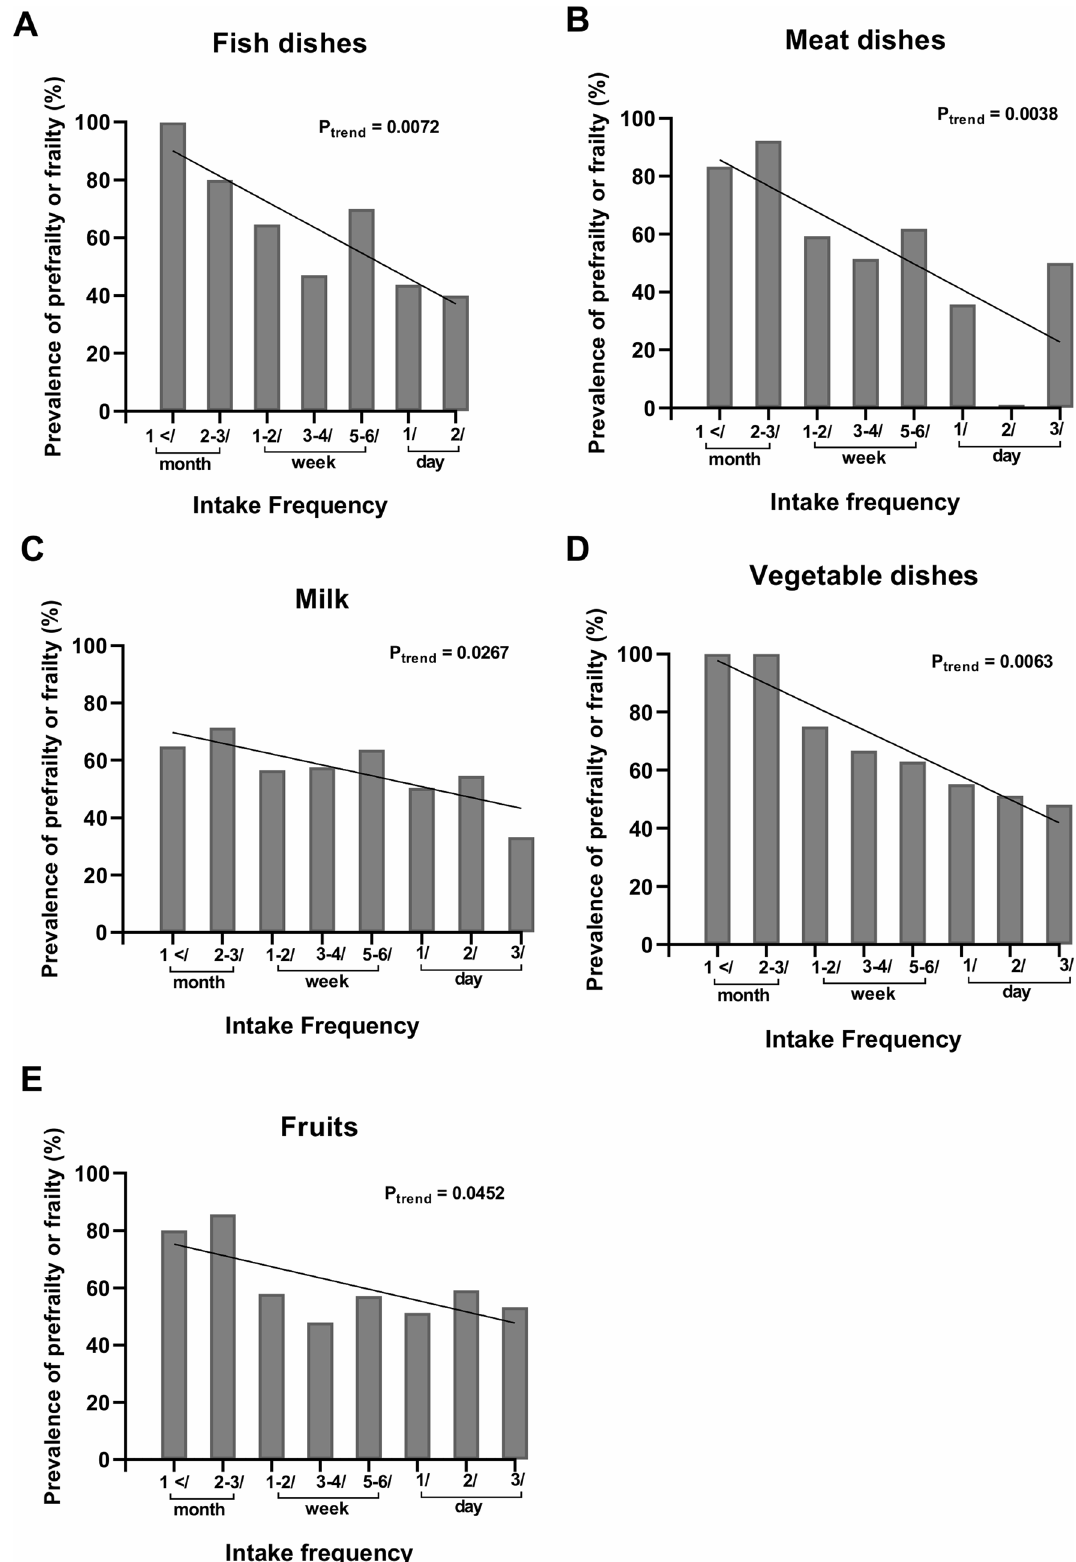
Figure 1. The prevalence of prefrailty or frailty for subjects by intake frequency. The vertical axis represents percentage of prefrailty or frailty in the categories of intake frequency. Five of the 20 groups are negatively correlated with the prevalence of prefrailty and frailty; fish ( A ), meat ( B ), milk ( C ), vegetable ( D ), and fruits ( E ). P trend values were obtained from the results of Cochran-Armitage trend